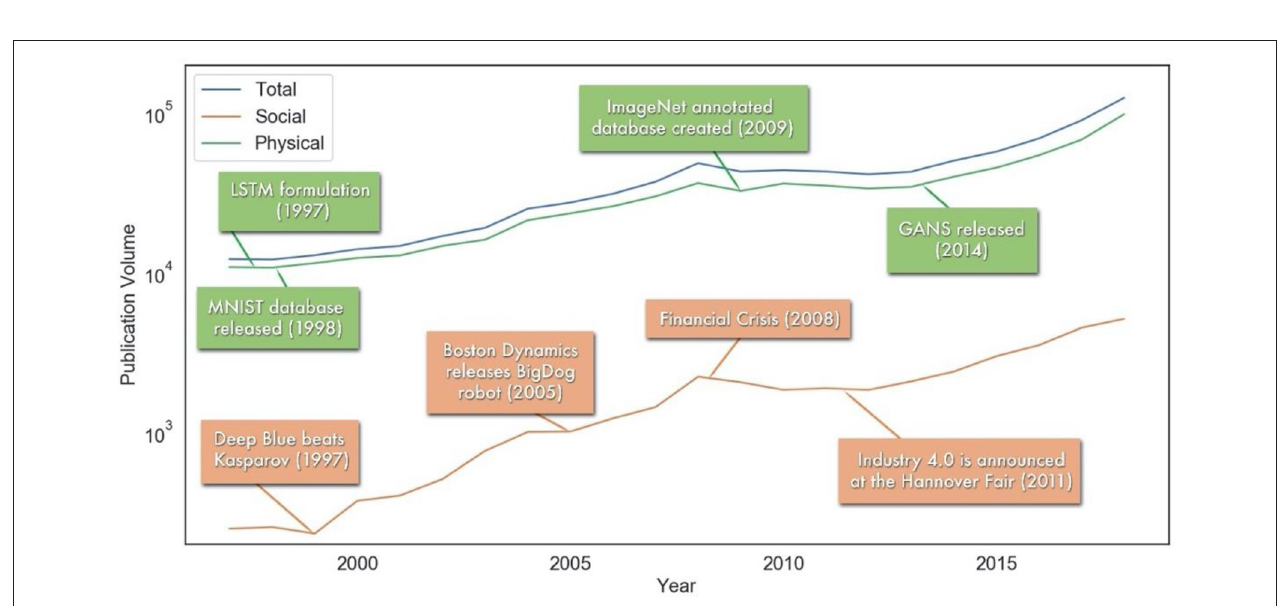
FIGURE 9 | Number of publications for the most frequent “social sciences”; “technical” pairs of keywords (1997–2018).